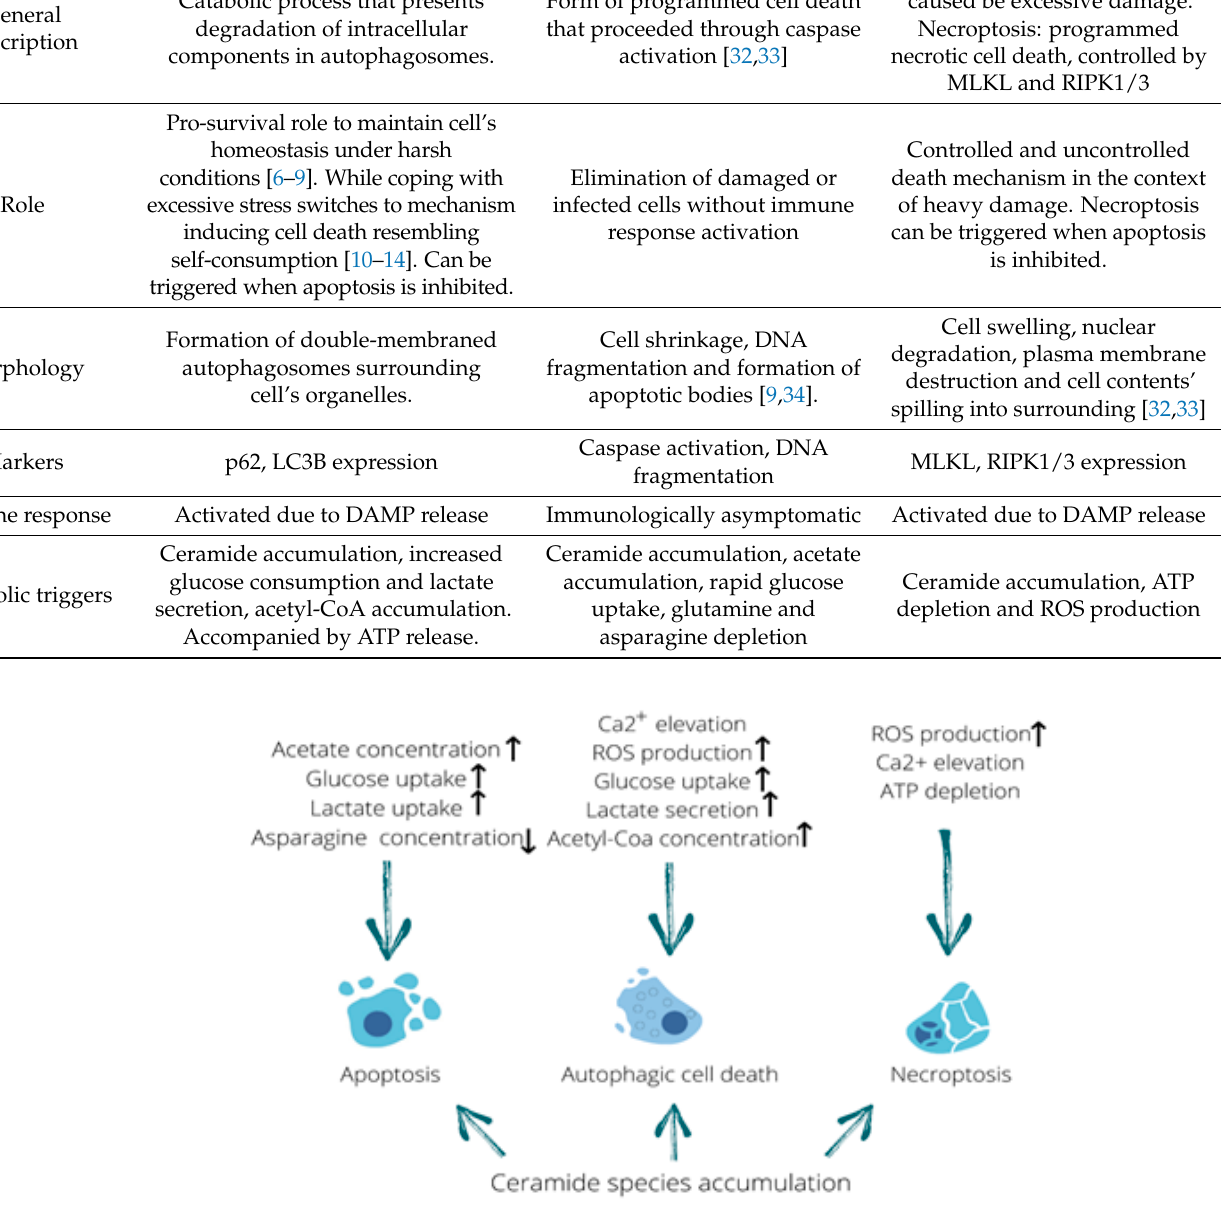
Figure 3. Metabolome fluctuations that trigger different types of cell death. Elevated